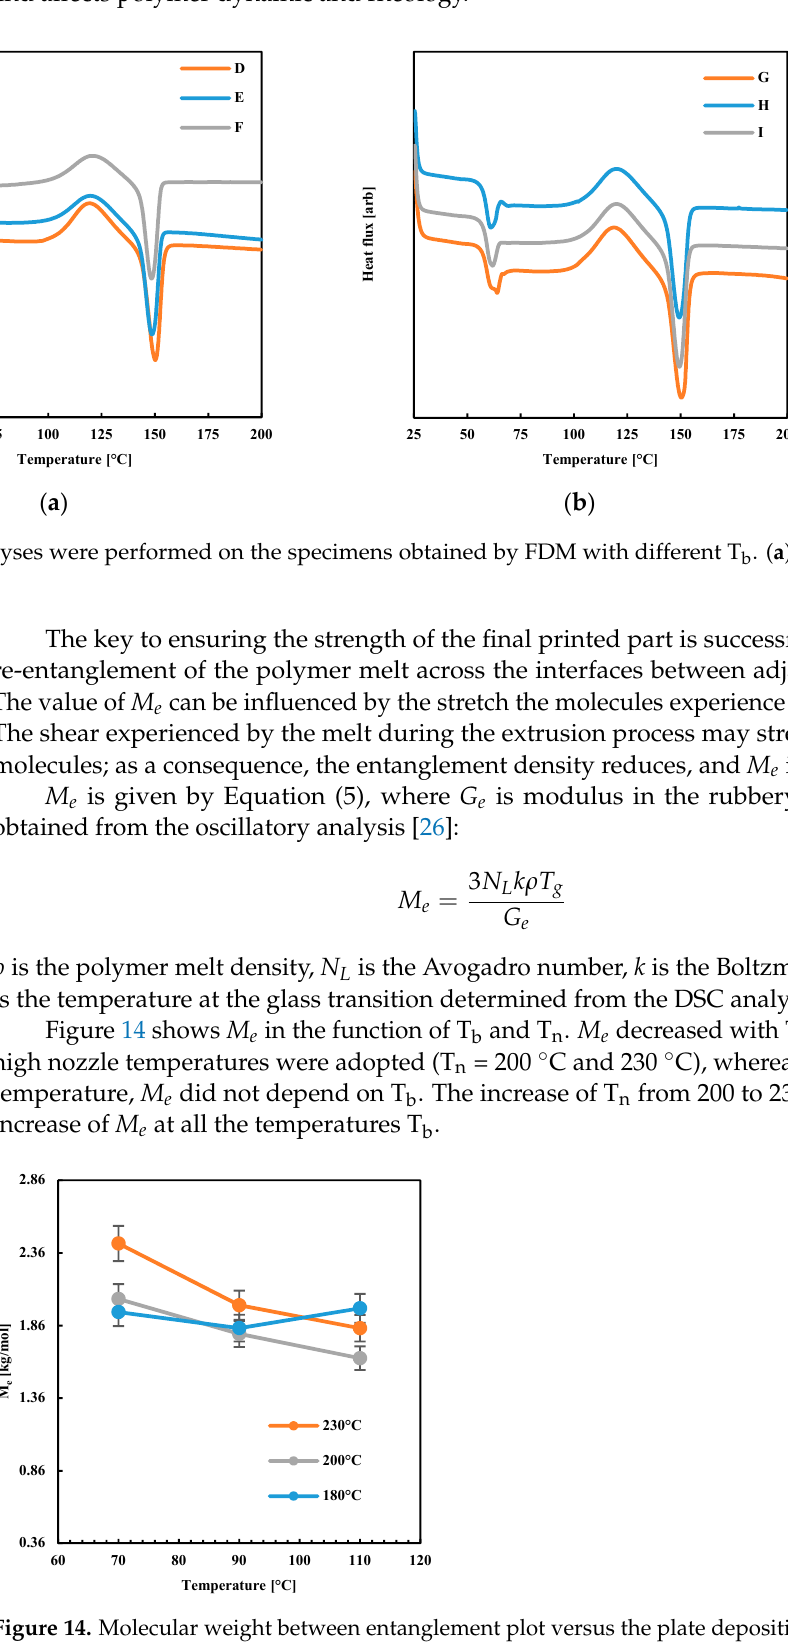
Figure 14. Molecular weight between entanglement plot versus the plate deposition temperature T b at different nozzle temperatures.